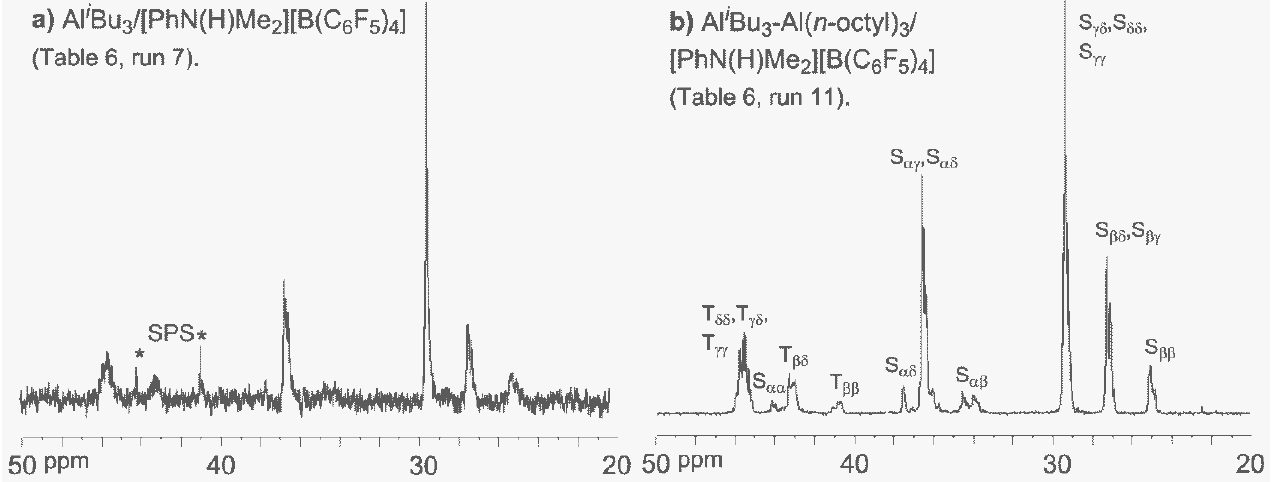
( O -2,6- i Pr C H ) ( 4 )–[PhN(H)Me 2 2 6 3